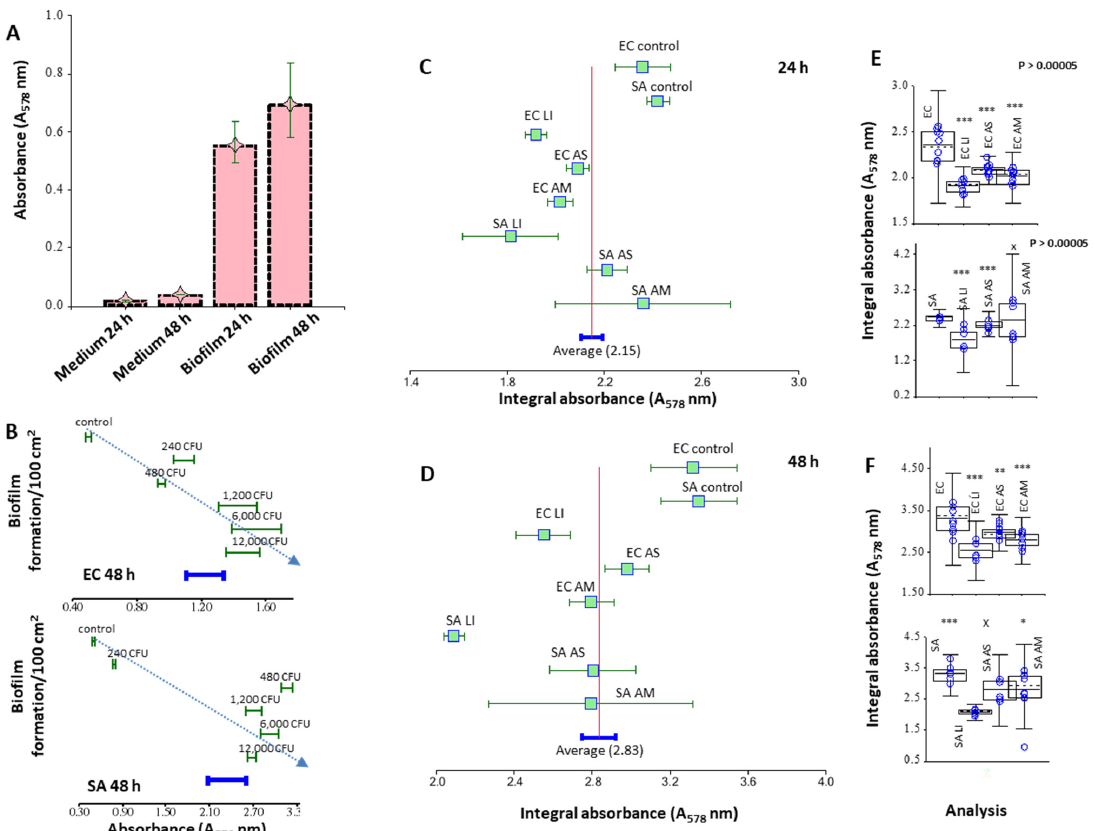
Figure 7. Spectrophotometric study of biofilm formation—Pyrogallol red method. Comparison of protein content in biofilm in 24 and 48 h against bacterial medium for E. coli ( A ). There are significant differences between protein content in media and biofilms and between 24 h and 48 h-biofilm. ( B ) Dependence of biofilm formation on CFU after 48 h. The protein content is increasing with a growing number of CFU. ( C ) Forest plot comparing the effect of using 20 μ g/mL of AgNPs from L. indica (LI), A. scholaris (AS), and A. multifolium (AM) on biofilms of S. aureus (SA) and E. coli (EC) against non-treated biofilms in 24 h and ( D ) 48 h. ( E ) Boxplots comparing the overall area of non-treated biofilms and biofilms treated with 20 μ g/mL AgNPs from LI, AS, and AM during 24 h and ( F ) 48 h.